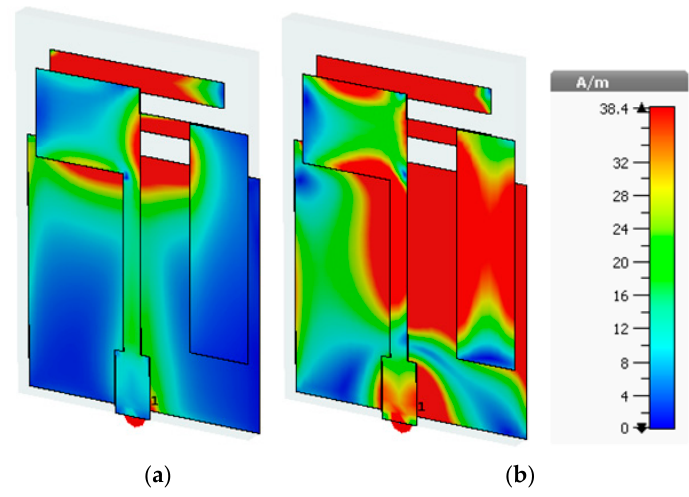
Figure 10. Surface current distribution ( a ) at 2.45 GHz; ( b ) at 5.8 GHz.